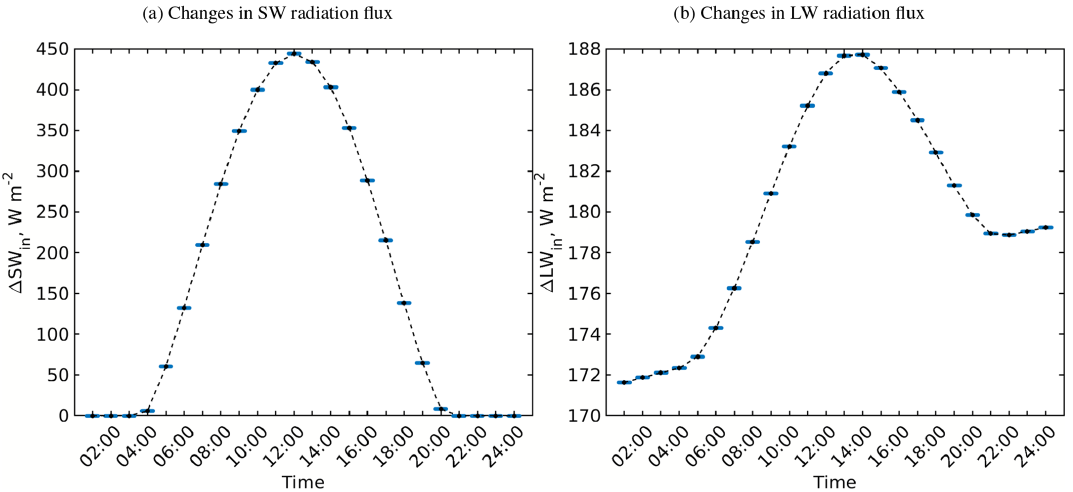
Figure 4. Changes in the received SW and LW irradiance within the focus domain of the simple urban configuration when applying the simple RTM (RTM_01) compared to the neutral case (RTM_00). Since all surfaces receive the same radiation in the simple RTM, the violin plots appear as concentrated points. The mean values are shown by a dashed black line and the median values are shown by black